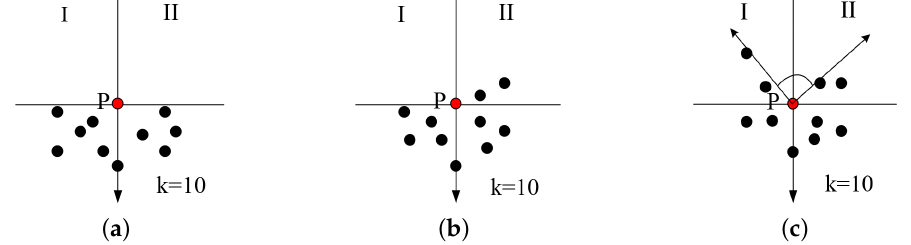
Figure 8. Three judgment conditions for obtaining the boundary points from the three-dimensional point cloud. ( a ) both areas have no points; ( b ) either one of the areas has no points; ( c ) the angle is smaller than (cid:101)